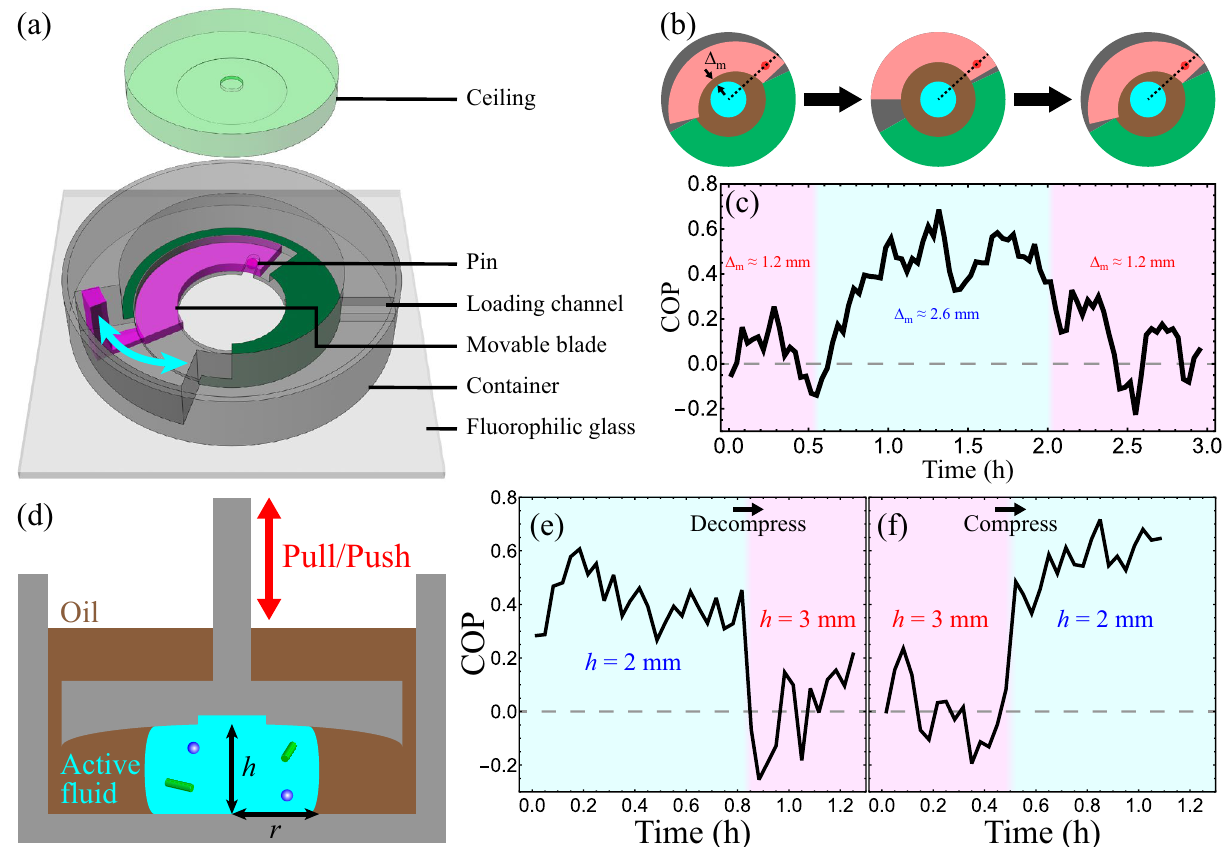
Figure 8. We created millifluidic devices that trigger and suppress intradroplet circulatory flows in real time by manipulating the oil layer thickness ( a – c ) or deforming the droplet ( d – f ). ( a ) Novel millifluidic device with a movable blade (pink) that allows the amount of oil surrounding the droplet to be tuned. ( b ) Schematics of manipulating the oil layer thickness with a movable wall (pink). The wall was anchored to a cylindrical container (gray) by a pin (red dot) that could move radially (dashed black lines). Moving the pin toward the container center rotated the wall counterclockwise and reduced the minimum oil layer thickness ( (cid:31) m ), whereas pushing the pin outward rotated the wall clockwise and increased the oil layer thickness. The corresponding 3D schematics are available in Supplementary Fig. S8. ( c ) The evolution of circulation order parameter (COP) of flows in a droplet ( r 2.4 mm, h 2 mm) revealed that increasing the minimum oil layer thickness ( (cid:31) m ) ≈ = regulated the chaotic flows into circulatory flows (left pink to middle cyan areas). Conversely, decreasing the minimum oil layer thickness suppressed the circulatory flows (middle cyan to right pink areas). A video of manipulating the formation and deformation of intradroplet circulatory flows using the wall-movable device is available in Supplementary Video S3. ( d ) Schematic of compressing a droplet with a movable ceiling to manually tune the droplet height. Because the droplet volume was conserved, decreasing the droplet height h enlarged the droplet radius r and vice versa. The schematic of realizing such ceiling manipulation is shown in Supplementary Fig. S9. ( e ) Circulatory flows within the droplet were suppressed by decompressing the droplet (cyan to pink areas). The decompression reduced the droplet radius from r 2.0 to 1.7 mm. ( f ) Conversely, compressing ≈ the droplet regulated the chaotic flows into circulatory flows (pink to cyan areas). The compression expanded the droplet radius from r 1.7 to 2.0 mm. A video of manipulating the formation and deformation of the ≈ circulatory flows with the ceiling-tunable device is available in Supplementary Video